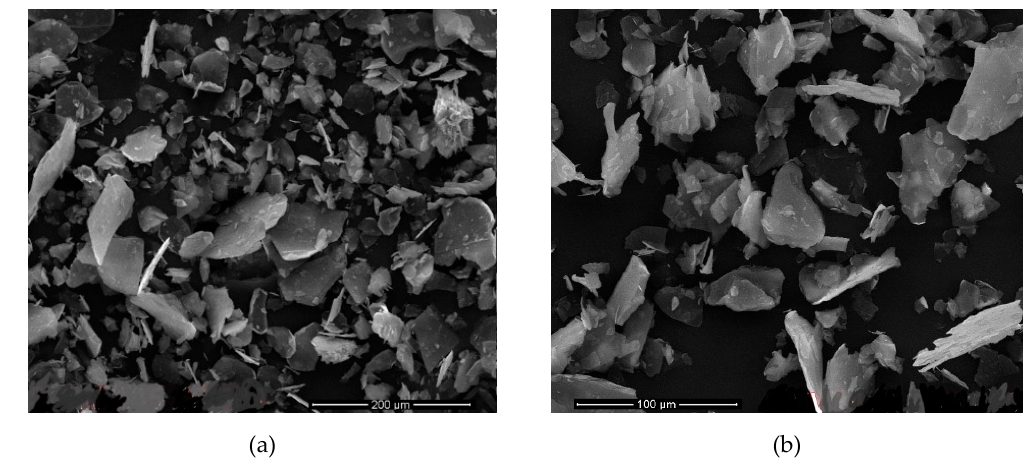
Figure 9. SEM images of the M x2c3 sample with a sonication time of 9 h with higher magnification ( a ) 500×; ( b ) 1000×.